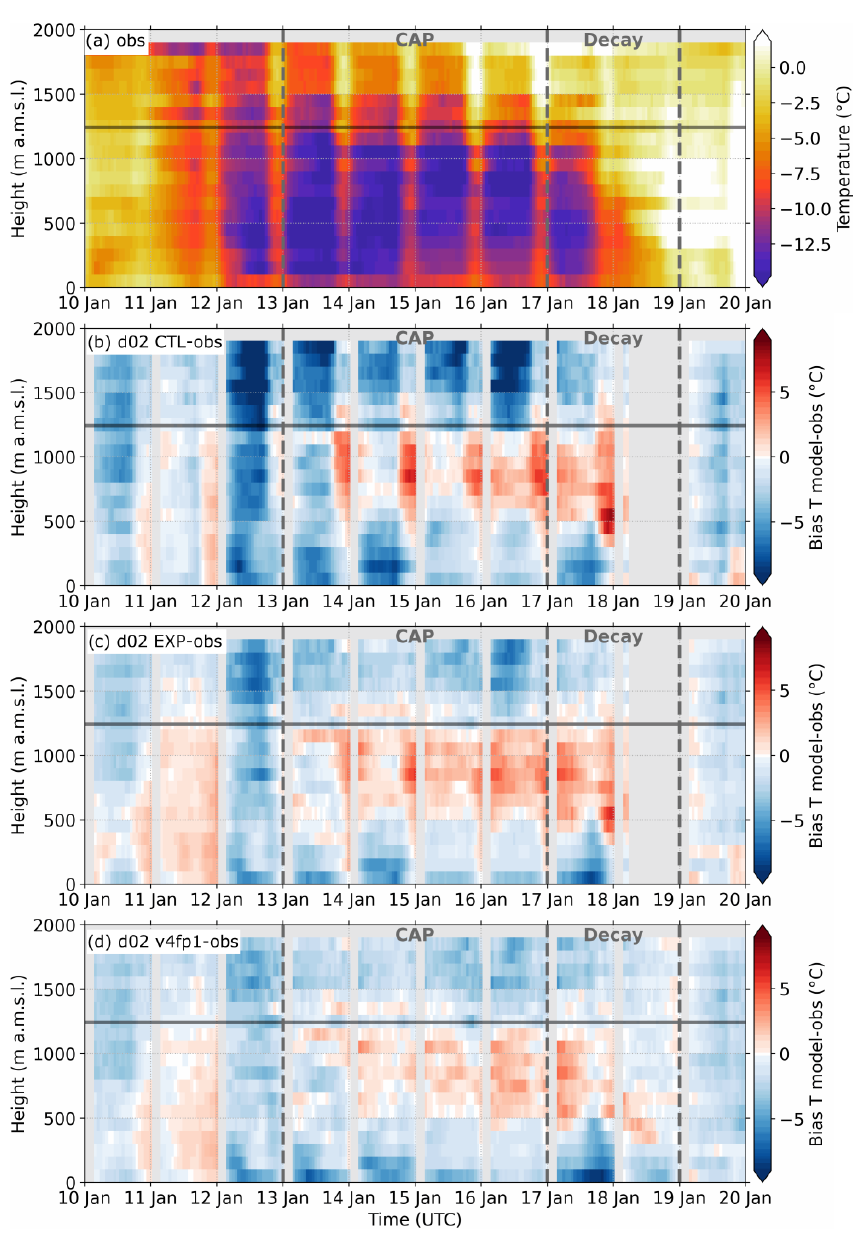
Figure 5. Time–height section of (a) observed near-surface temperature and of the temperature ( T ) bias between d02 (b) CTL, (c) EXP, and (d) v4fp1 and the observed values using data from more than 500 stations distributed in the Columbia River basin (locations in Fig. 1). Values are averaged over 100m height bins. The horizontal gray line indicates the mean ridge height, and the light gray shading indicates missing data. The CAP and Decay periods are indicated by the vertical dashed